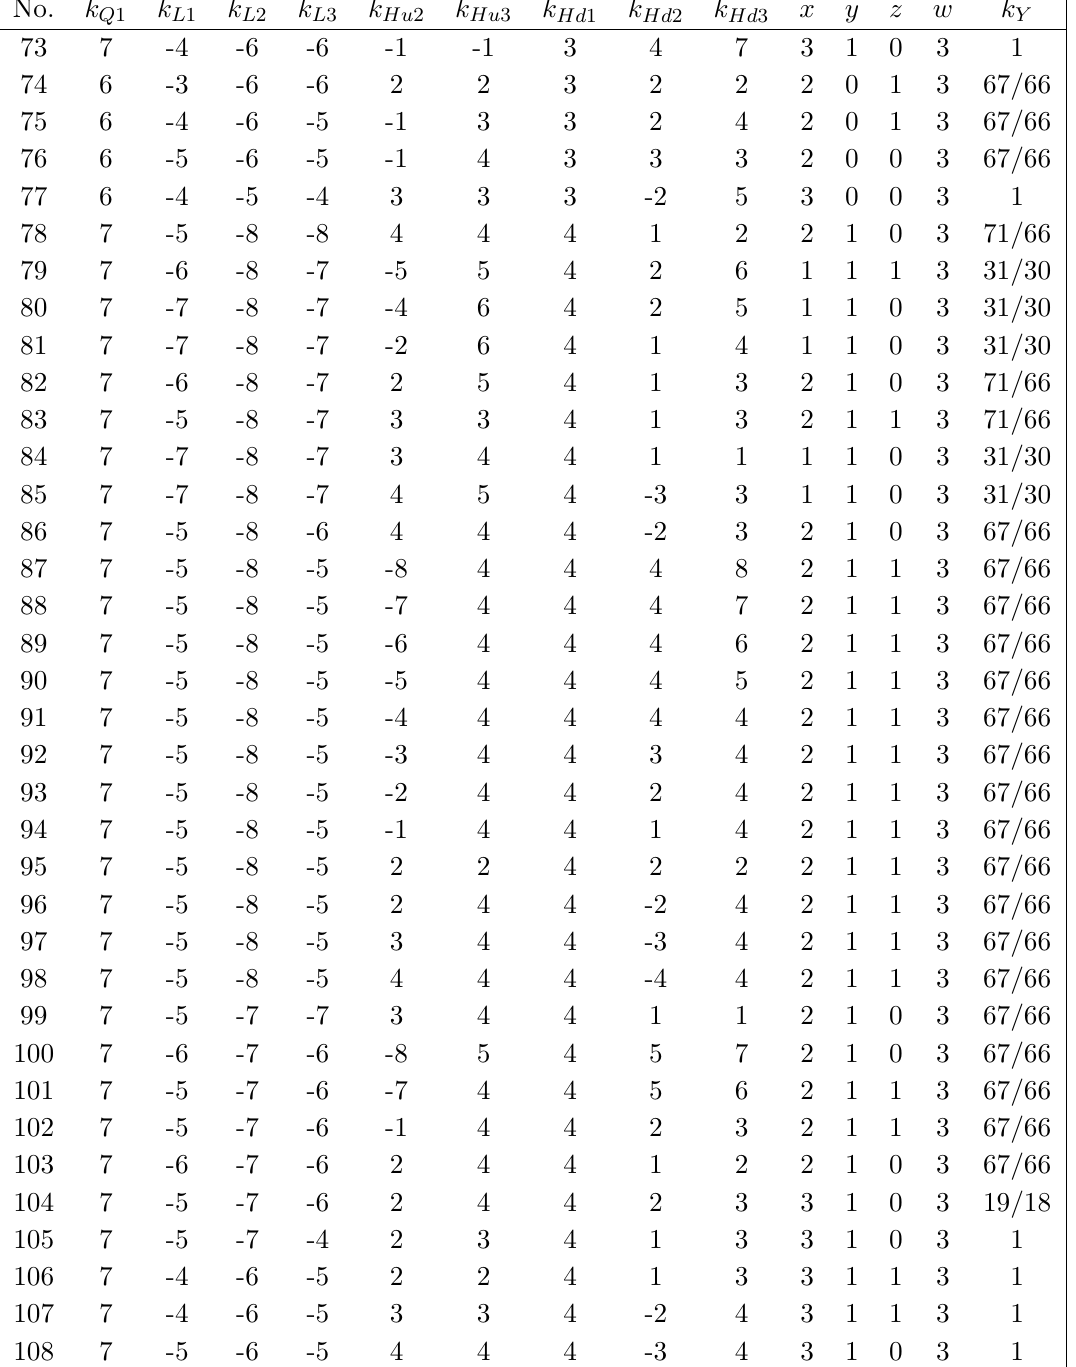
Table 9 . The parameters of the charge assignment ( N h = 3) conti.2